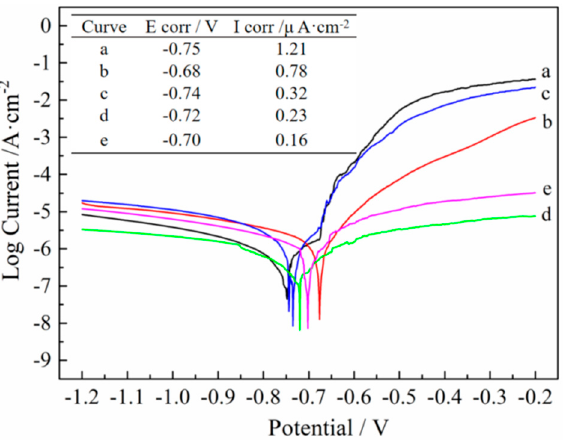
Figure 9. Polarization curves and anticorrosion properties of ( a ) Al-12 Si matrix, ( b – e ) Al-12 Si with etching for 0, 15, 30, 60 s, respectively, and then 30 min of MAO treatment.